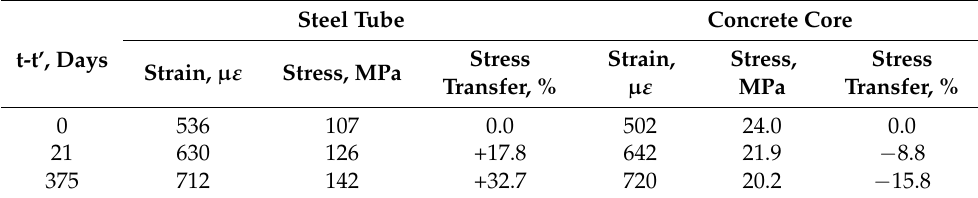
Table 7. Vertical strains, stresses and stress transfer of CFT